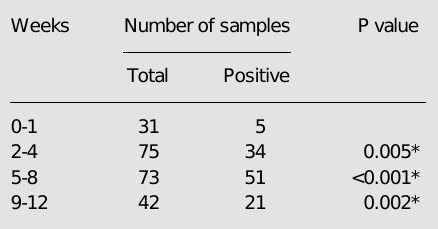
Figure 2 - Clinical and laboratory aspects that may be related to the CMV infection observed in the 33 renal transplant recipients with CMV detected in blood